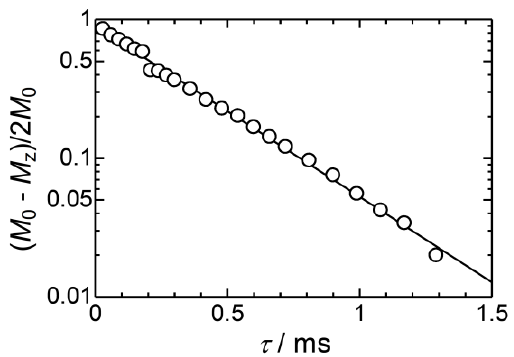
Figure A2. 1 H magnetization recovery curve at 233 K for the closed form of ELM-11 determined by the inversion-recovery method.